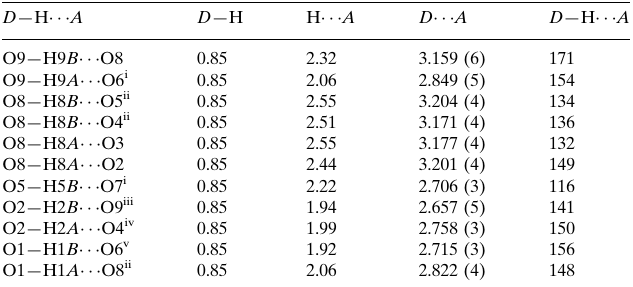
Hydrogen-bond geometry (A˚ , (cid:2)